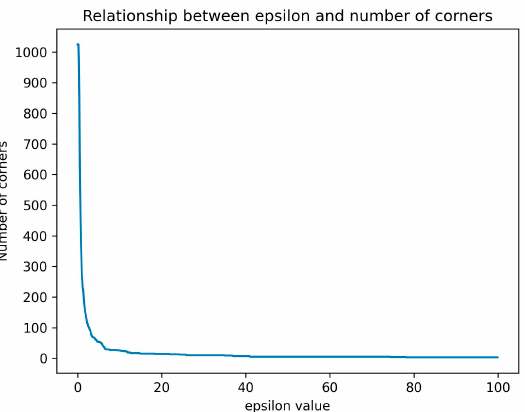
Figure 12. Relationship between epsilon and number of corners.